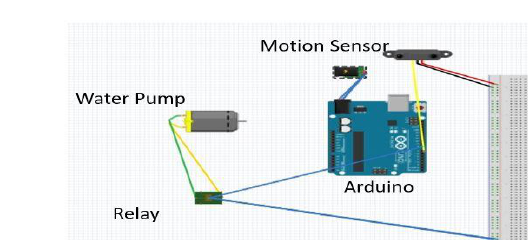
Figure 2 – System hardware sketch Рис. 2 – Эскиз системы аппаратного обеспечения Слика 2 – Скица хардверског